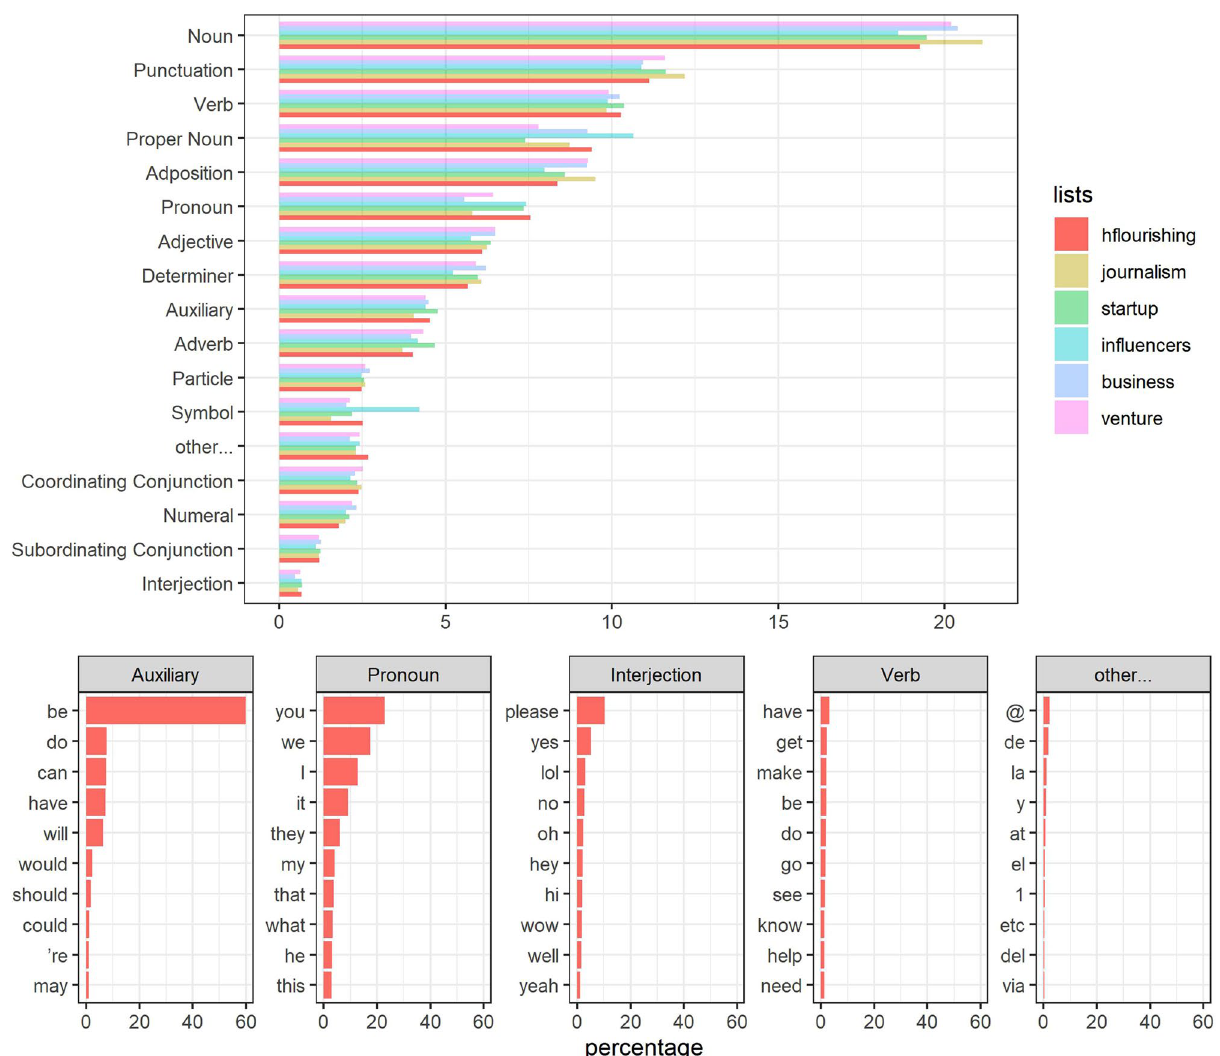
Figure 5. Above: a plot showing the percentages of the different POS tags for each list. Below: those POS tags where the HF list stands out the most, showing which specific words are the most frequent for each of them. Graphs were made by the authors, using R